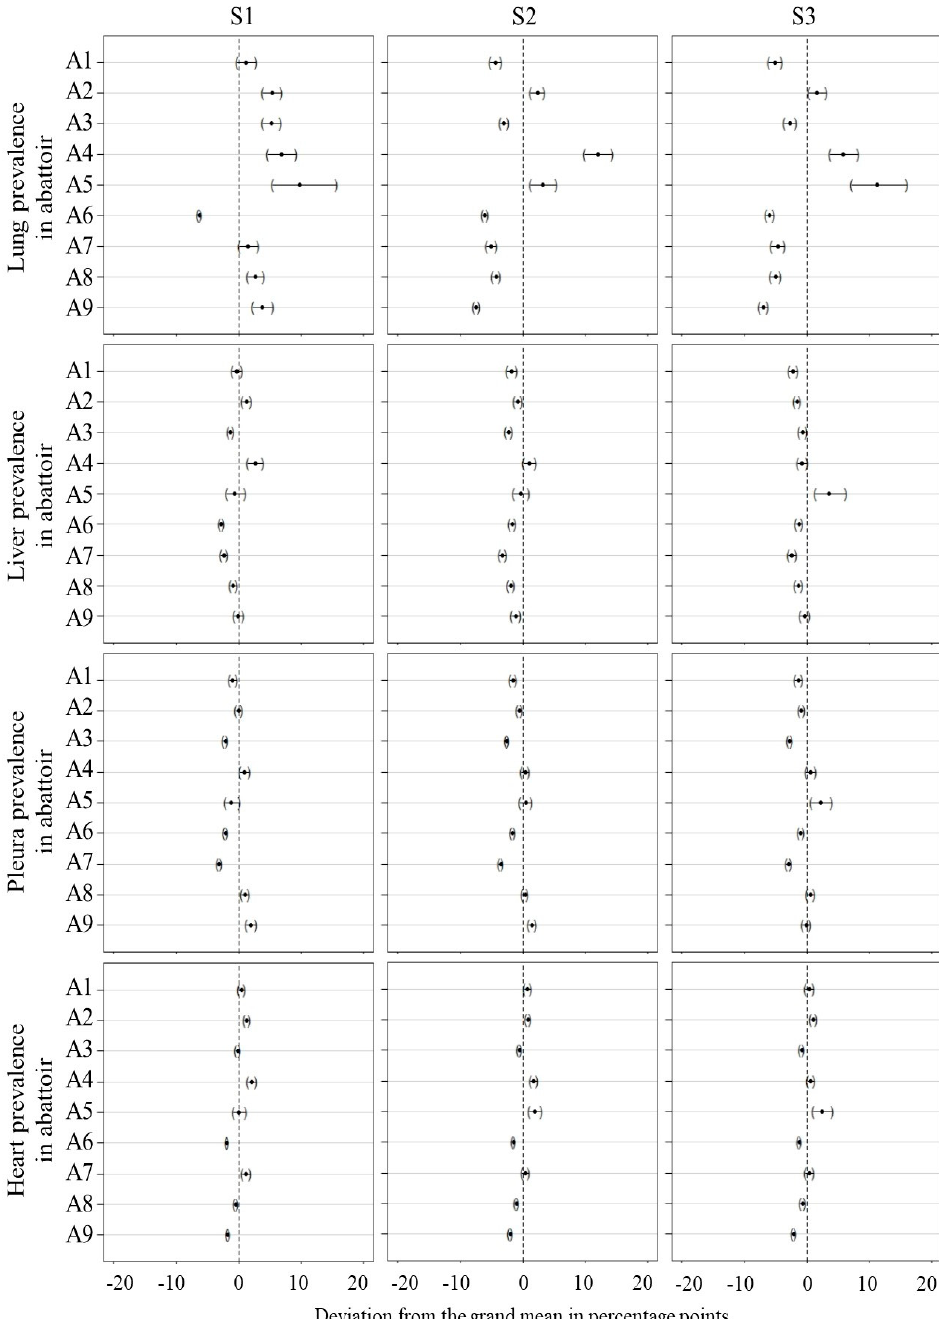
Figure 4. Deviations in lung, liver, pleura, and heart prevalence of abattoirs mean compared to the grand mean of the respective six-monthly period (S1–S3). Dot = abattoir deviation; bracket = 90% confidence interval; dashed line = grand mean. Calculated grand means (GM) based on the LSM of each abattoir in S1: GM lung = 8.35%, GM heart = 3.59%, GM pleura = 5.19%, GM liver = 5.46%; S2: GM lung = 10.8%, GM heart = 3.91%, GM pleura = 5.55%, GM liver = 6.97%; S3: GM lung = 11.4%, GM heart = 3.88%, GM pleura = 5.68%, GM liver = 5.80%).